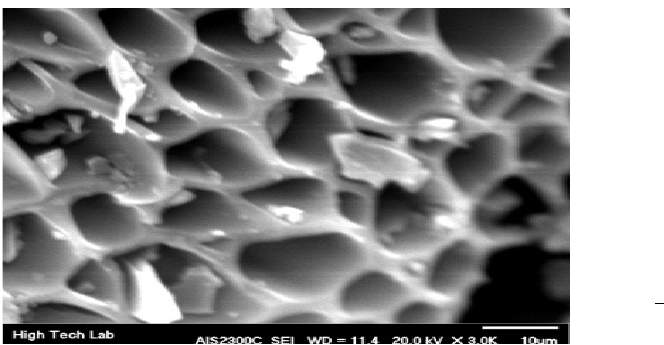
Fig. 2. SEM micrographs (3000X) of